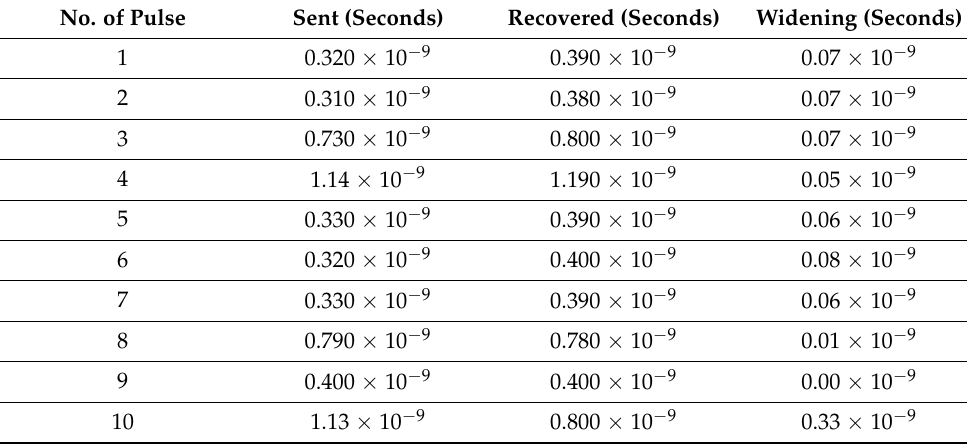
Table 2. Width of pulses sent and recovered.